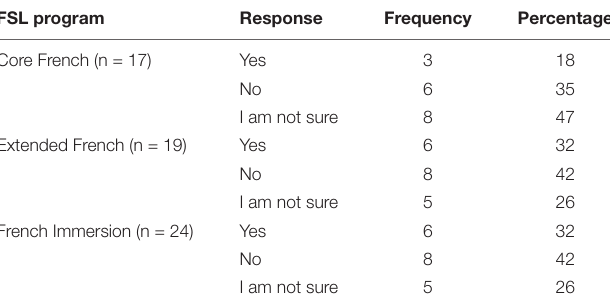
TABLE 2 | Distribution of multiple-choice responses for question 1: Do you feel like students in your French program formed or acted like a group in any way? FSL program